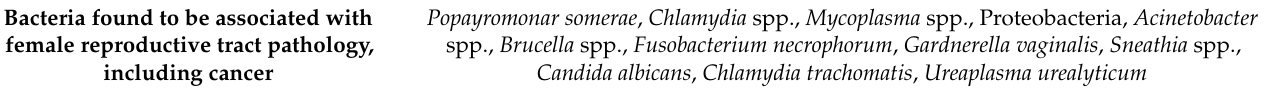
Table 2. Examples of bacteria associated with female reproductive tract